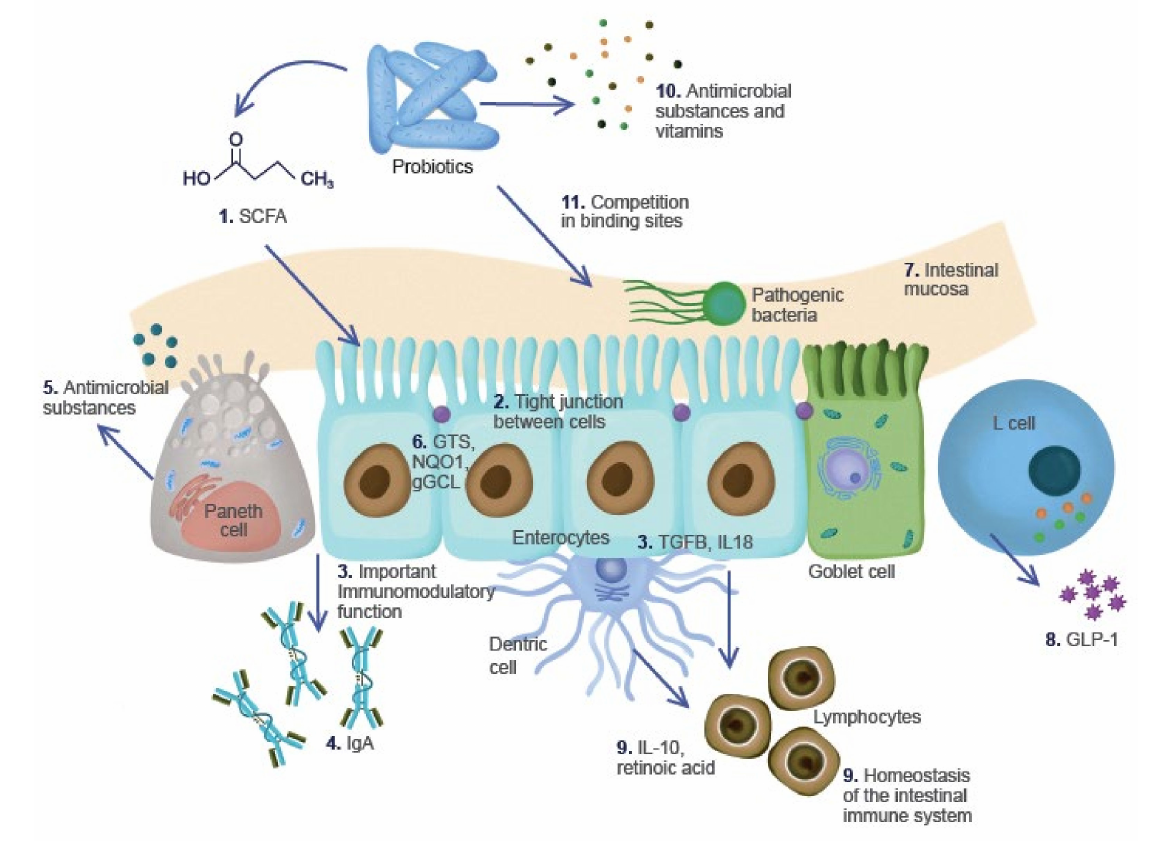
Figure 1. Probiotic functions. (1) Short-chain fatty acids (SCFA: butyrate, propionate, acetate) are the main sources of energy of intestinal cells. (2) The adequate function of enterocytes increases the barrier function and prevents the passage of pathogens. (3) Enterocytes inhibit the production of pro-inflammatory cytokines IL-6*, TNF- α * and IFN- γ *, and stimulate the production of TGFB and IL-8* for lymphocyte recruitment, which maintains the immune balance. (4) With the help of Paneth cells, they also produce immunoglobulin A (IgA). (5) Paneth cells produce antimicrobial substances (alpha defensin and lysozymes). (6) They possess antioxidant properties, promoting the synthesis of protection mechanisms against reactive oxygen species (ROS), glutathione S-tranferase (GSTs), NAD (P) H: quinone reductase (NQO1) and glutamicylcysteine ligase gamma (gGCL), among others. (7) Goblet cells produce intestinal mucus. (8) L cells stimulate the synthesis of GLP-1. (9) Macrophages and dendritic cells use butyrate, stimulating the production of IL-10 and retinoic acid that also recruit lymphocytes and participate in the homeostasis of the immune system. (10) Probiotics synthesize vitamins (K, B5, B8, B9 and B12) and other substances such as lactic acid and hydrogen peroxide that act as antimicrobials. (11) They can compete and fight against pathogens. *IL-6: Interleukin-6; TNF- α : Tumor Necrosis Factor alpha, IFN- γ : Interferon gamma; TGFB: Transforming growth factor beta; IL18: